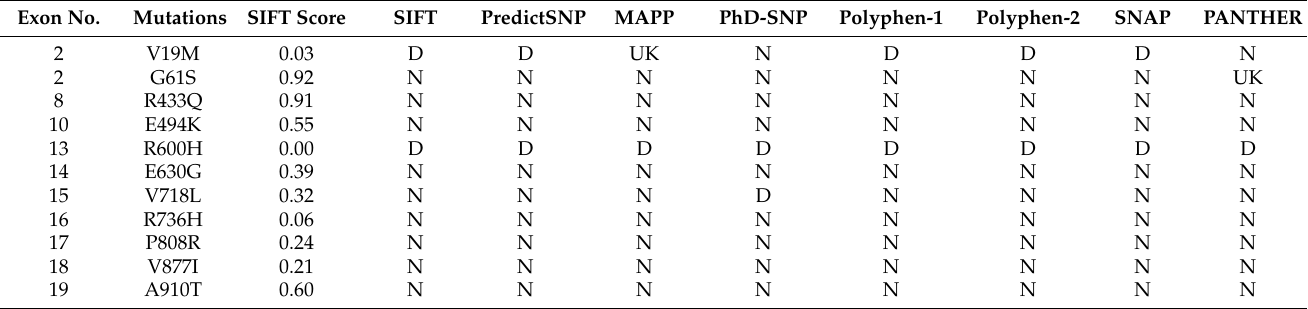
Table 1. Analysis of missense mutations in the catalytic site of the GAA protein using the SIFT and PredictSNP servers.